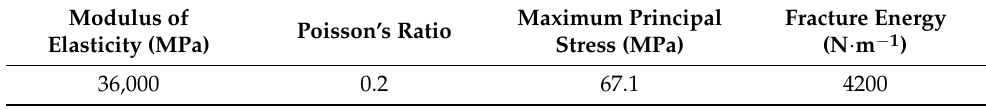
Table 1. Concrete material parameters [23].